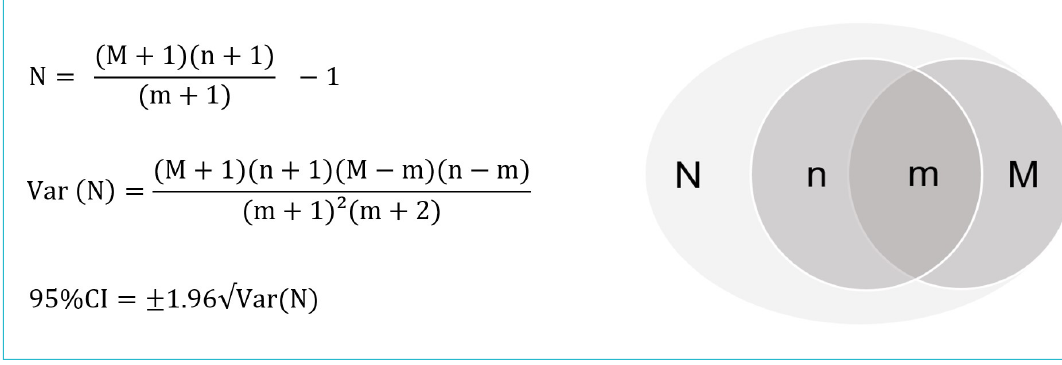
Figure 1: Formula by Chapman [14] with a schematic illustration of the capture-recapture method.N corresponds to the total of patients with diabetes mellitus in our study population, M to the number of patients identified by means of Helsana and n the number of identified patients through the Inselspital; m is the overlap of the patients found in both